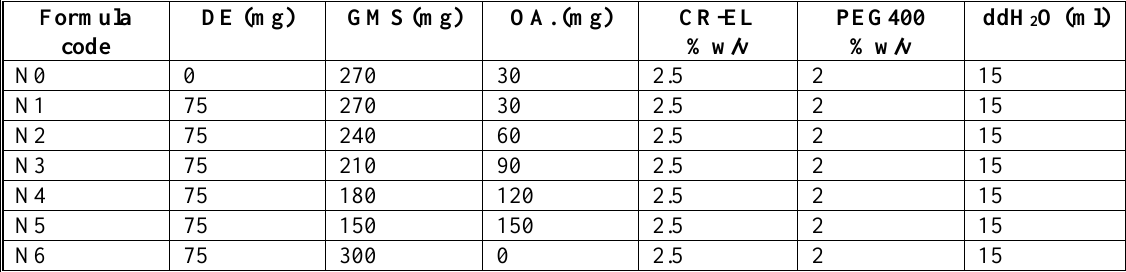
Table 1. Composition of different formulas of DE-loaded NLCs